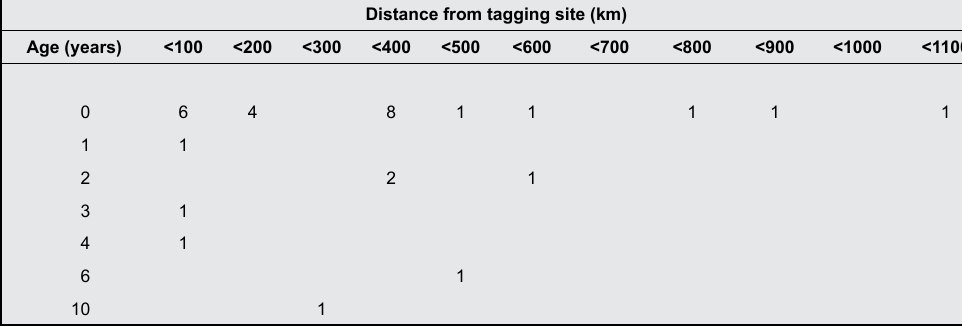
Table 2. Recoveries of grey seals tagged on Ainov and Seven Island on the Murman coast, Rus- sia and distance from tagging